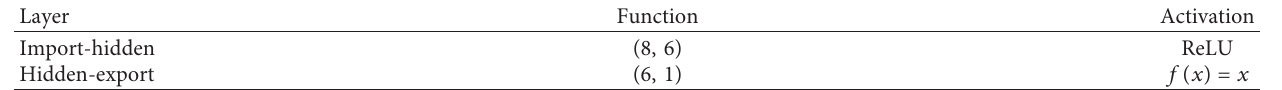
Table 7: Parameters of the benchmark model.